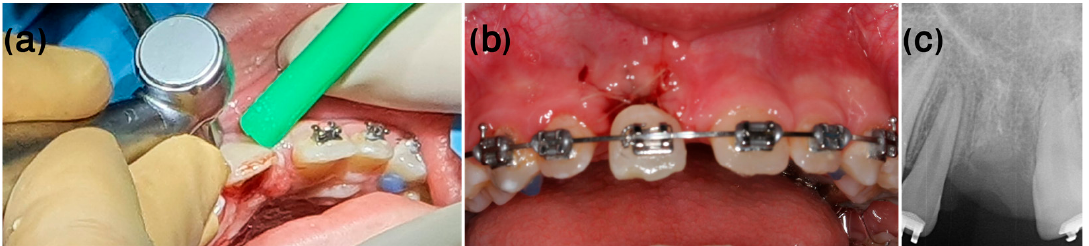
Figure 13. Case 2, flapless decoronation procedure. ( a ) Removing the clinical crown using a tungsten bur. ( b ) Coated VICRYL ® (polyglactin 910) sutures were used to stabilize the PDCM over the ex- posed root. ( c ) Radiographic appearance at the end of the procedure.